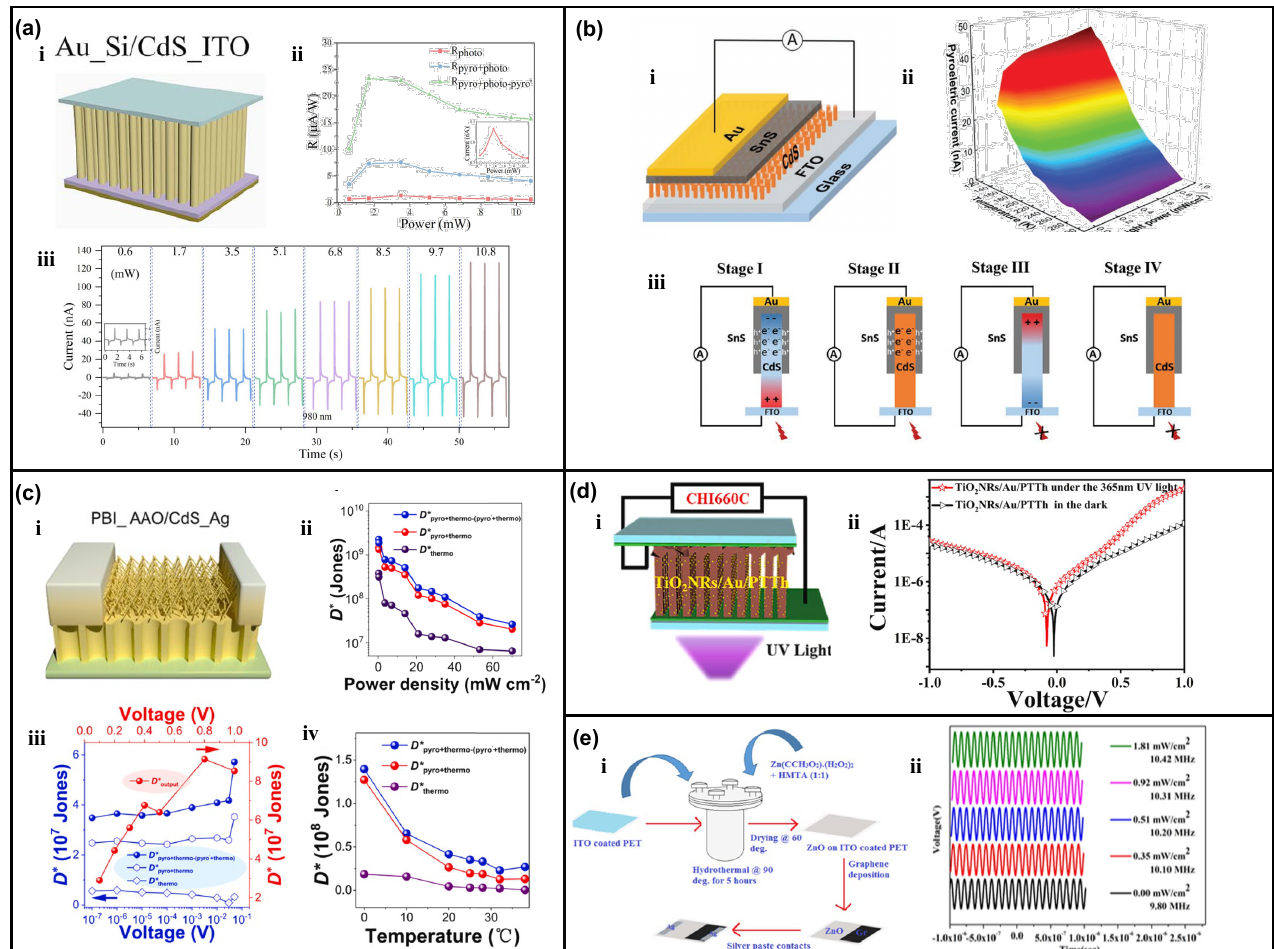
Figure 6. ( a ) Pyro-phototronic-effect-enhanced broadband photodetection based on CdS nanorod arrays. (i) Schematic demonstration of the p-Si/n-CdS heterostructure photodetectors; (ii) R pyro + photo , R photo , and R pyro + photo −pyro′ of the photodetectors as a function of the power. Inset: Corresponding R photo of the self-powered photodetectors as a function of the power; (iii) I–t characteristics of the self-powered photodetectors with different power. Inset: Enlarged I–t characteristics with a 0.6 mW power. Reproduced with permission from [54]. Copyright 2022 Royal Society of Chemistry; ( b ) Structural design and pyroelectric property of SnS/CdS heterojunctions contrived for low-temperature visible photodetectors. (i) The schematic structural diagram of the SnS/CdS heterojunction; (ii) 3D mapping image of temperature, light power intensity, and pyroelectric current; (iii) Diagrammatic sketch of the basic working mechanism on the coupled pyroelectric–photoelectric effects. Reproduced with permission from [55]. Copyright 2020 Wiley; ( c ) Photoresponse characteristics of the self-powered PBI_AAO/CdS_asy-Ag photodetector under 660 nm illumination at different conditions. (i) Schematic demonstration of PBI_AAO/CdS_asy-Ag photodetectors; (ii) Corresponding R pyro + thermo −(pyro΄ + thermo) , R pyro + thermo and R thermo of the self-powered photodetector as a function of the power density; (iii) Corresponding R pyro + thermo- (pyro΄ + thermo) , R pyro + thermo , and R thermo of the self-powered photodetectors as a function of the bias voltage from 0 to 50 mV, and the R output of the self-powered photodetectors as a function of the bias voltage from 0.1 to 1 V; (iv) Corresponding R pyro + thermo − (pyro΄ + thermo) , R pyro + thermo , and R thermo of the photodetector as a function of the background environmental temperature. Reproduced with permission from [56]. Copyright 2022 Elsevier; ( d ) Self-powered TiO 2 NRs UV photodetectors. (i) The schematic diagram of the self-powered ultraviolet detector; ( ⅱ ) I-V curves of TiO 2 NRs/Au/PTTh heterojunctions. Reproduced with permission from [57]. Copyright 2022 Elsevier; ( e ) Pyro-phototronic nanogenerator based on flexible 2D ZnO/graphene heterojunction and its application in self-powered near-infrared photodetector. (i) Schematic of the fabrication procedure for pyrotronic graphene/ZnO diode; (ii) Frequency modulation with different intensities showing only ‘ON’ state frequencies. Reproduced with permission from [59]. Copyright 2018 Institute of Physics.